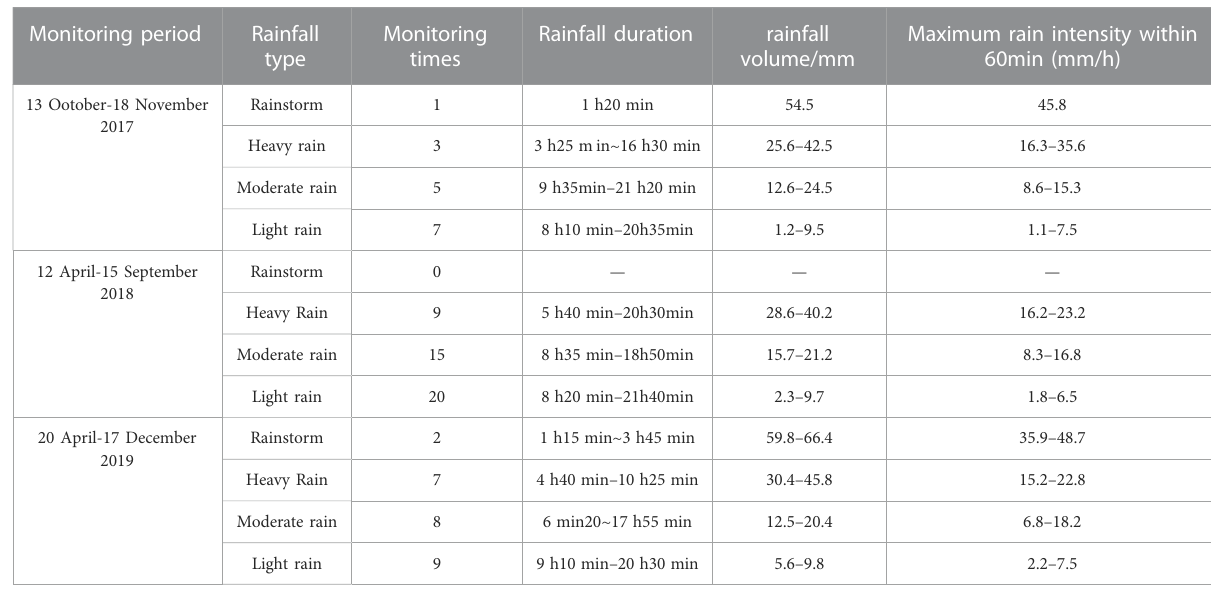
TABLE 1 Rainfall characteristics.